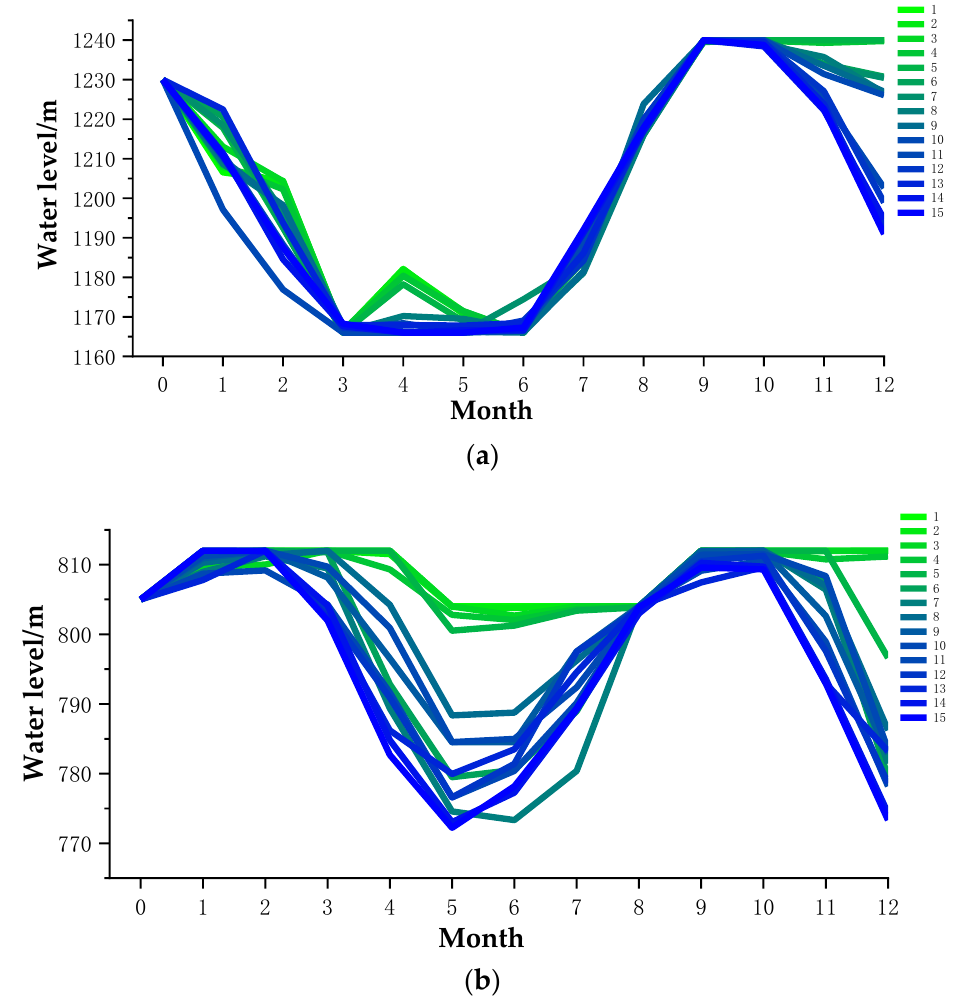
Figure 6. The optimization process of regulating reservoirs in schemes 1 to 15. ( a ) Xiaowan; ( b ) Nuozhadu.